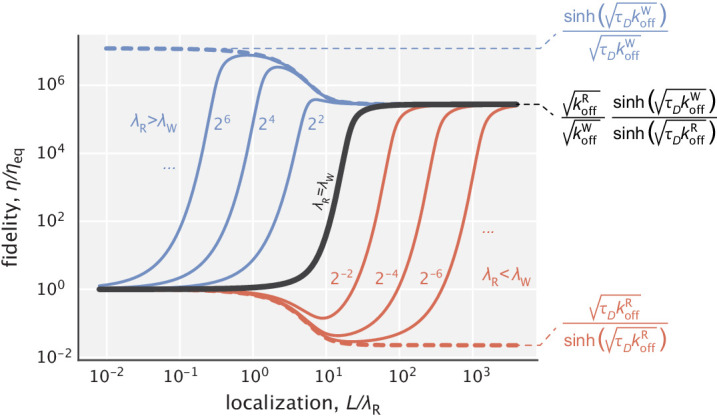
Fidelity as a function of L/λR for different choices of the ratio λR/λW.The solid black line corresponds to the earlier studied regime where substrates had identical localization length scales. The blue curves represent the cases where λR>λW, while the red curves represent the cases where λR<λW. Numbers next to the curves correspond to the λR/λW ratios used for generating them. Expressions for the highest and lowest fidelity values, as well as the fidelity expression in the limit where both substrates are highly localized are shown on the right side of the figure. τD=40⁢τoffR and ηeq=10 were used for demonstration.